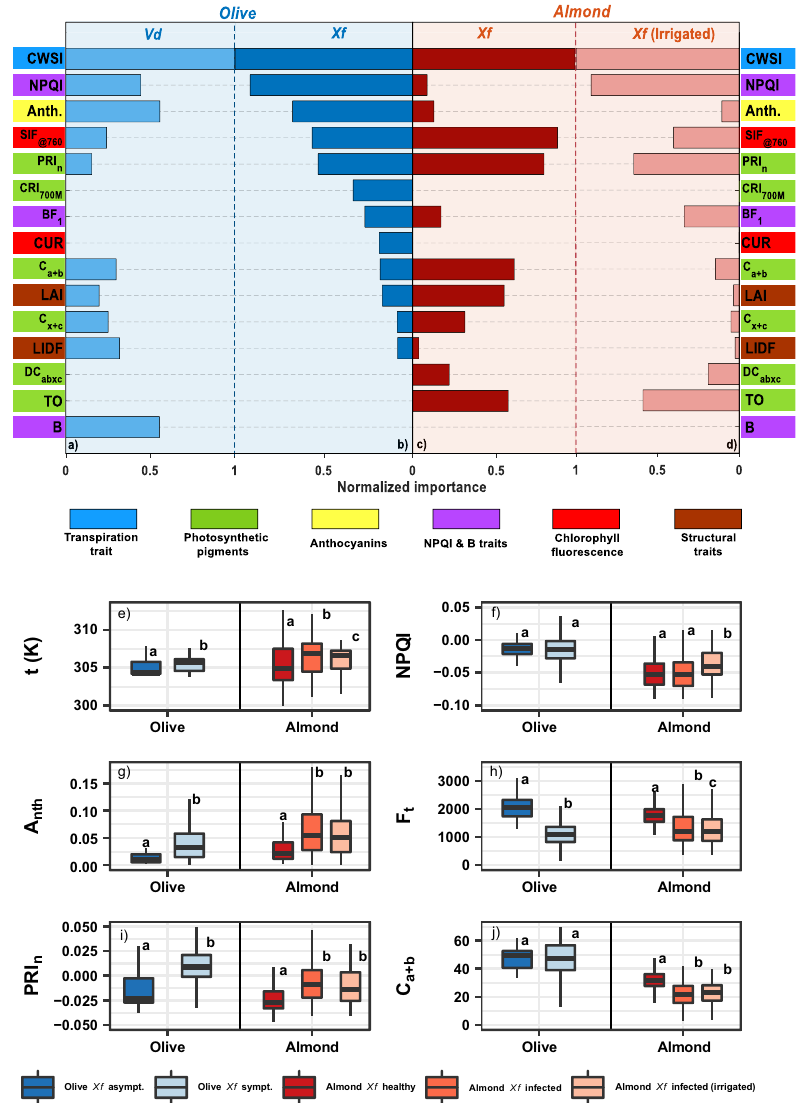
Fig. 2 Importance of spectral traits to detect Xf - and Vd -infection symptoms. a – d Normalised importance of hyperspectral and thermal plant traits retrieved from the pool of spectral plant traits used to detect Verticillium dahliae, Vd- ( a ) and Xylella fastidiosa , Xf -induced infection symptoms ( b – d ) across olive ( a , b ) and almond ( c , d ) trees. For reference, the full list of spectral plant traits is available in the Supplementary Table 1. The importance analysis was carried out using a balanced training dataset obtained from n = 1878 ( a ), n = 7296 ( b ), n = 4048 ( c ), n = 2680 ( d ) trees by the permutation of out-of-bag (OOB) predictor methodology. The importance of each spectral trait was normalised by the highest importance obtained for each disease/species within each ML model. e – j Analysis of spectral plant traits measured in the fi eld from asymptomatic vs. Xf- infected olive and almond leaves. e Temperature at midday (t, n = 1797 leaf samples). f Normalised phaeophytinization index-based spectral trait (NPQI, n = 1457 leaf spectral samples). g Anthocyanins (Anth, n = 1318 leaf samples). h Steady-state leaf chlorophyll fl uorescence (F t , n = 2784 leaf samples). i Normalised xanthophyll cycle dynamics index (Photochemical Re fl ectance Index [PRI n ], n = 1457 leaf spectra samples). j leaf chlorophyll content (C a + b , n = 2584 leaf samples). Statistical analyses were carried out by a one-way non-parametric ANOVA (Kruskal-Wallis test) followed by a Wilcoxon post-hoc test (two-sided) with Bonferroni correction